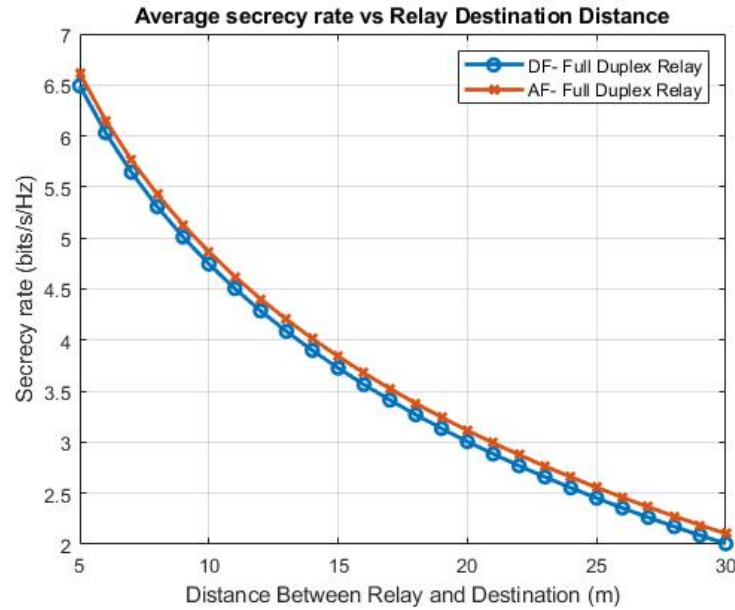
Figure 8. Secrecy Rate vs d R 2 D for the proposed EH PS System.